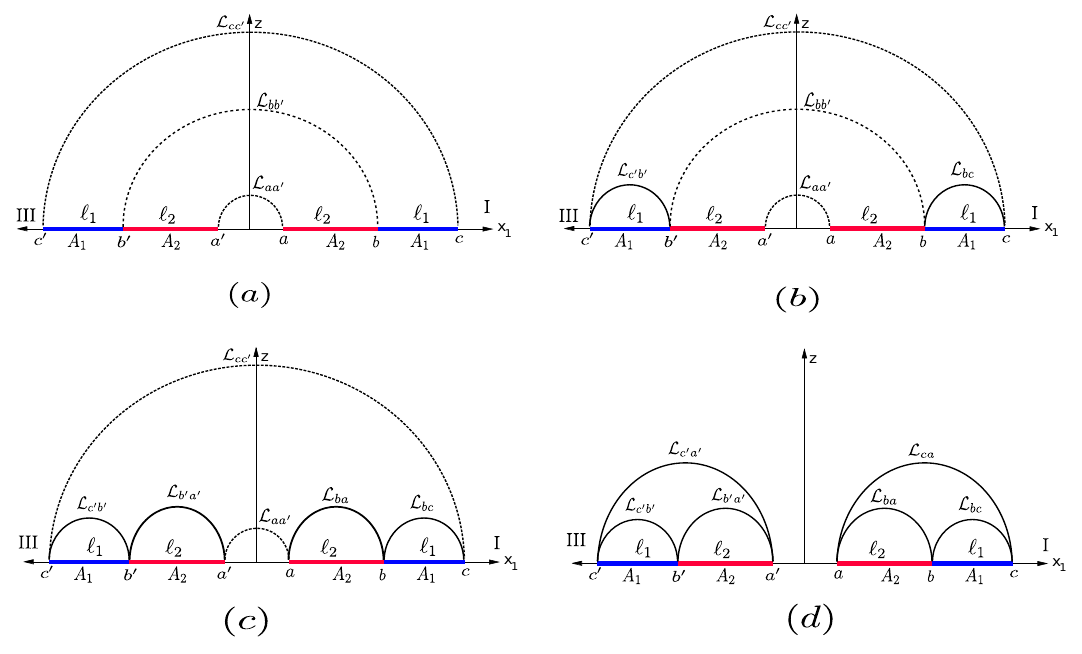
Figure 9 . Geodesic configurations for differnt limits of the time with the lenghts of the intervals. The geodesics shown by dashed line pass through the interior region of the BTZ black hole con- necting two rindler wedges. The geodesics shown by solid line confine at the exterior region of the BTZ black hole and they do not pass through the interior